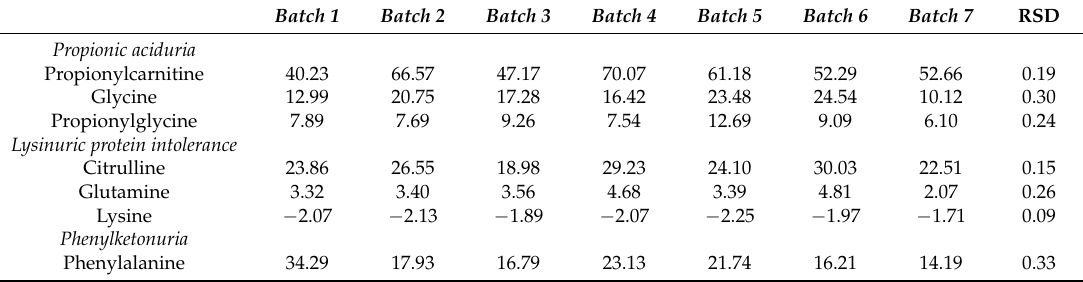
Table 3. Between-batch variation: relative standard deviation of Z-scores of positive control